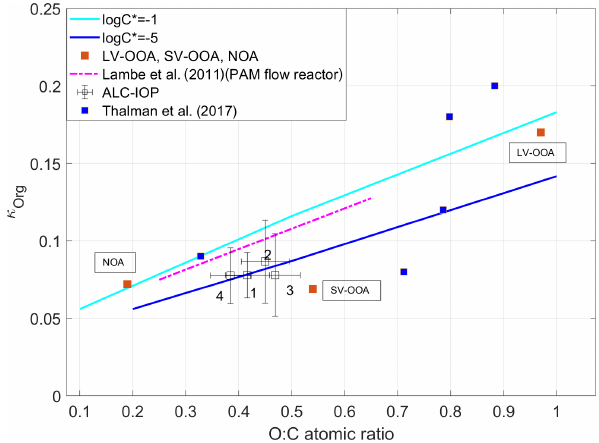
Figure 2. Derived κ org as a function of O : C atomic ratio for four clusters, and the κ org values of SOA positive matrix factorization (PMF) factors (LV-OOA, SV-OOA, NOA) derived from measure- ments during the ALC-IOP. Also shown with the predicted varia- tion for organics with a mean logC ∗ equals to − 1 and − 5, and the κ org values of SOA PMF factors from measurements during GoA- mazon 2014/5 (Thalman et al., 2017), and the relationship between κ org and O : C for SOA derived from a laboratory study (Lambe et al.,